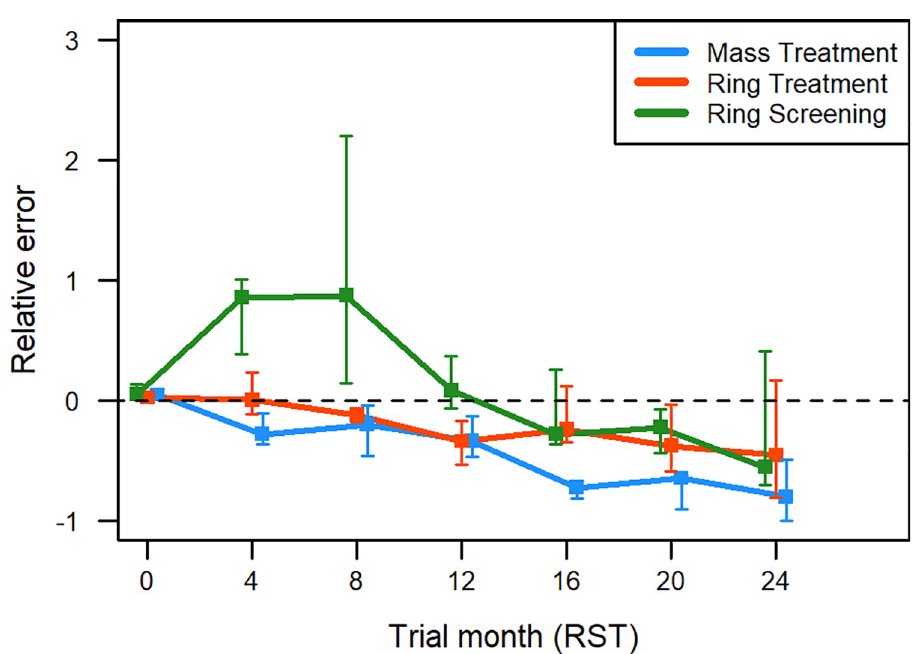
Fig 4. Relative errors of porcine seroincidence during validation of CystiAgent against result from the Ring Strategy Trial, by intervention type–ring treatment (n = 6 villages), ring screening (n = 8 villages), and mass treatment (n = 7 villages). Each time point represents the 4-month cumulative seroincidence across the 24-month trial period, as measured by enzyme-linked immune-electro transfer blot (EITB) in pigs. Error bars show inter-quartile range for relative errors among village in each intervention. Within each intervention type, villages with and without pig treatment are combined.